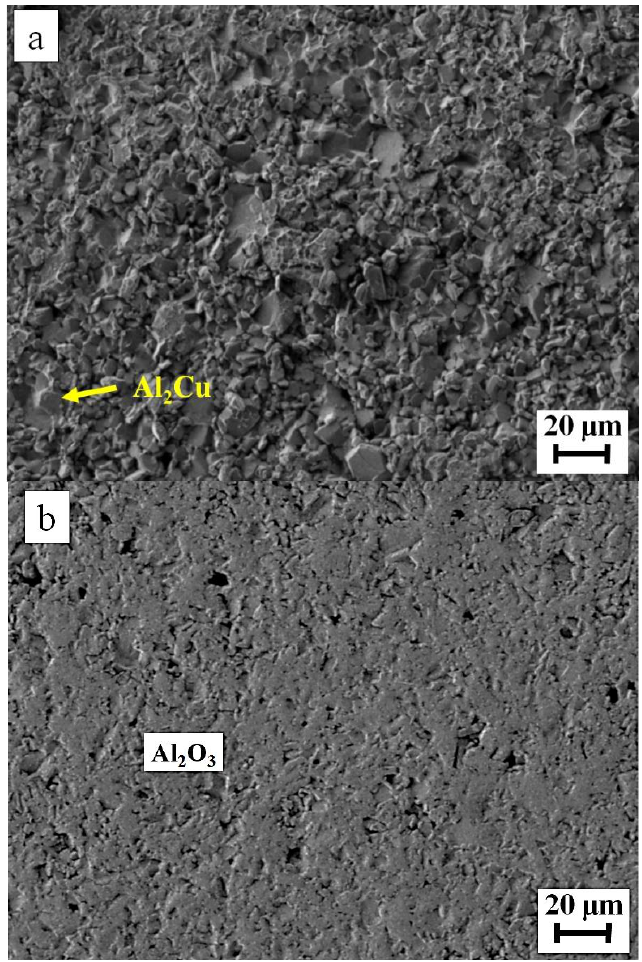
Figure 11. Fractography of the aluminum alloy/alumina joint bonded with the Al10.8Si10Cu filler alloy: ( a ) AA6061 side and ( b ) alumina side.